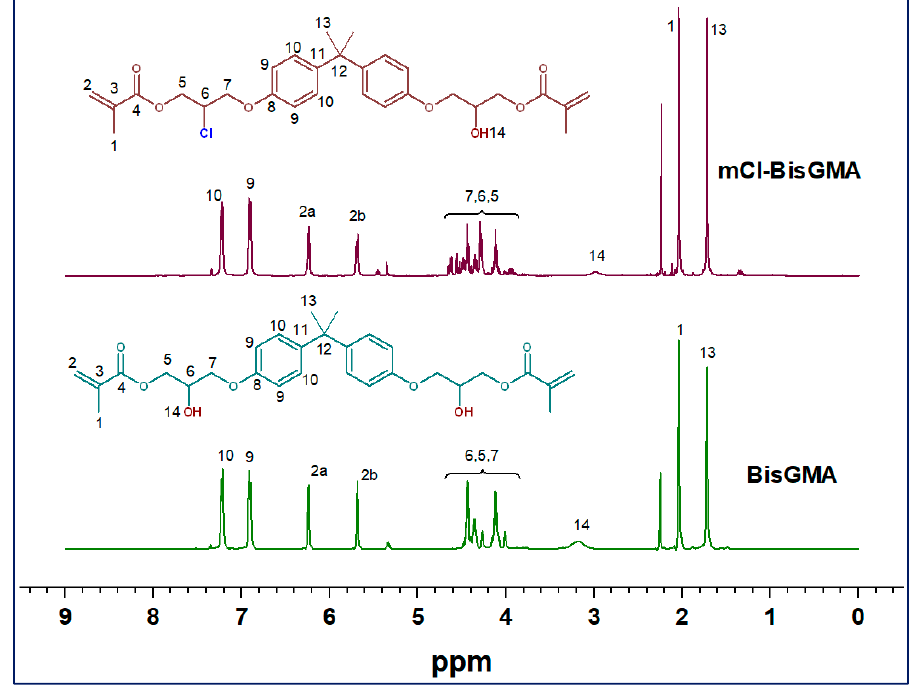
Figure 3. 1 H-NMR spectra of BisGMA and mCl-BisGMA in CDCl 3 .